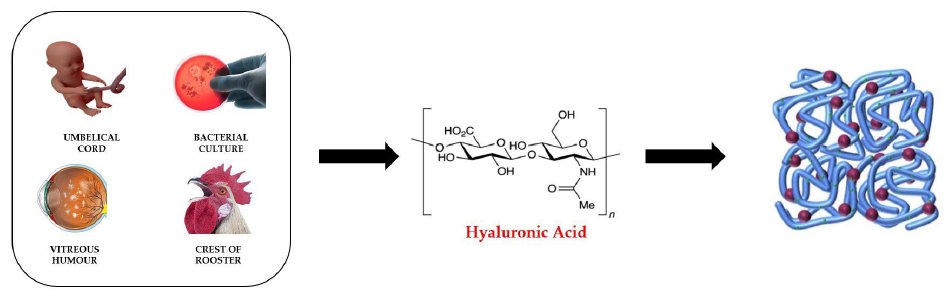
Figure 7. Hyaluronic acid molecule, sources and hydrogel production.